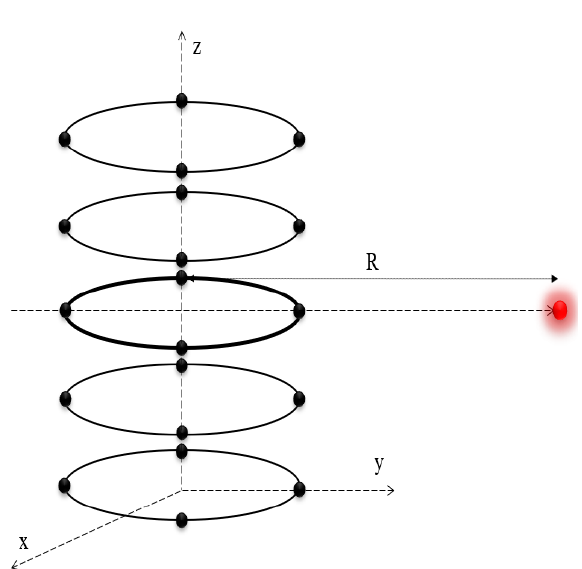
Fig. 1. Model of focused antenna